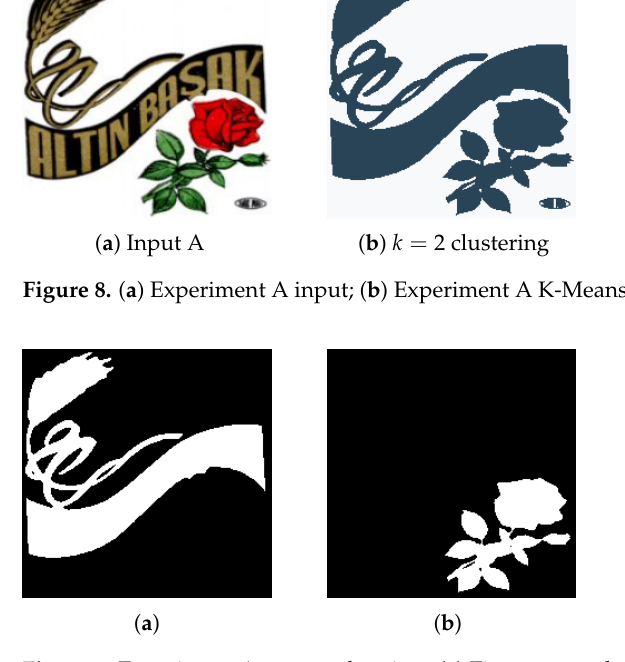
Figure 9. Experiment A extracted regions ( a ) First extracted region; ( b ) Second extracted region.